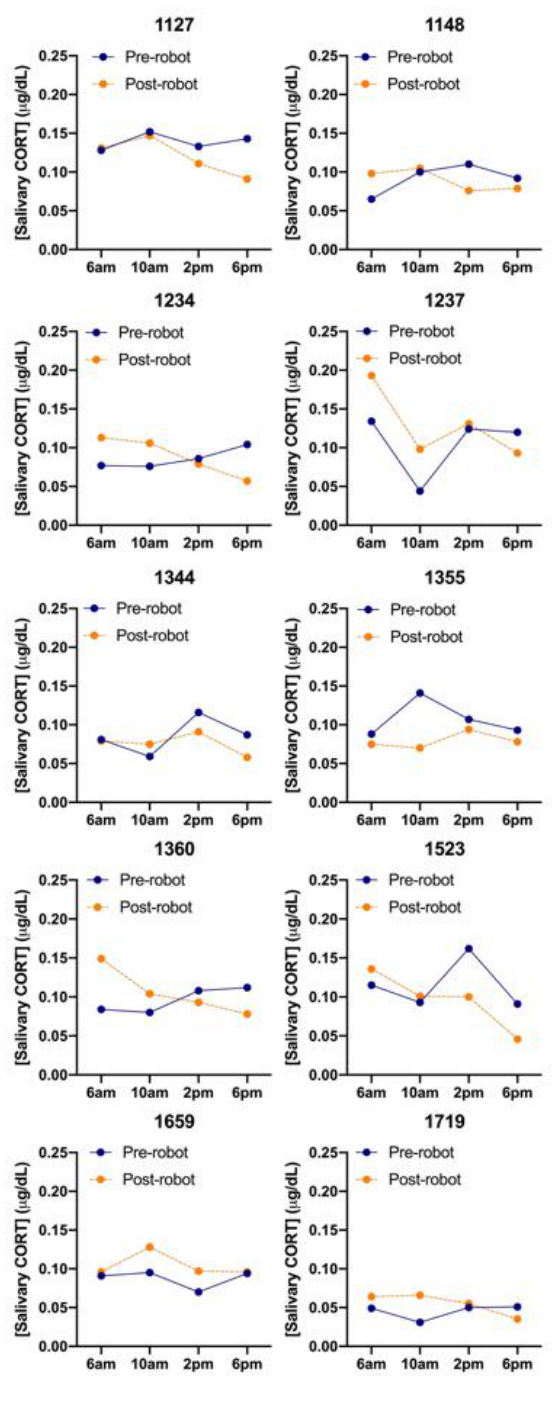
Figure 5. Salivary cortisol (CORT) levels ( µ g / dL) averaged for each sampling session (total samples = 160) for each individual cow ( n = 10), before (solid line) and after (dashed line) AMS